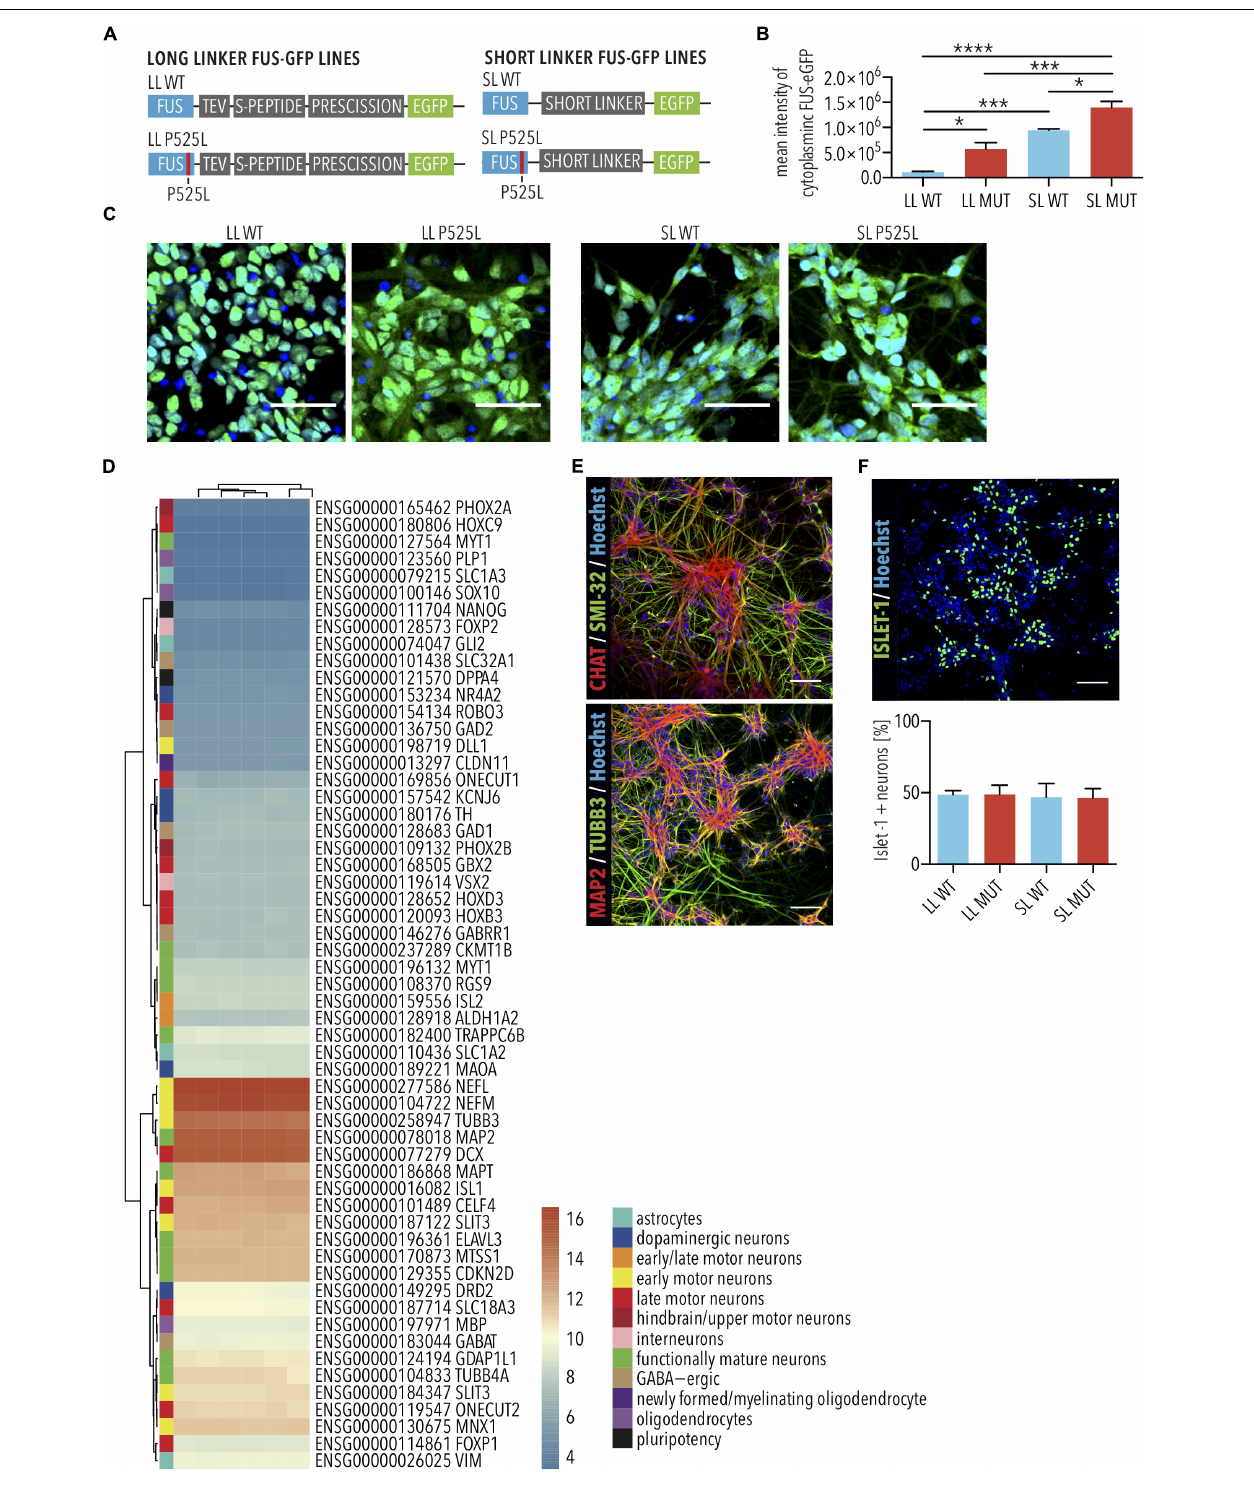
FIGURE 1 | Characterization of FUS-eGFP induced pluripotent stem cell (iPSC)-derived spinal neurons. (A) Schematic view explaining long (LL) and short linker (SL) (gray) connecting eGFP (green) to the C-terminus of wild type and P525L FUS (blue). (B,C) Spinal neurons with LL and SL P525L FUS-eGFP lines show increased mislocalization of FUS-eGFP to the cytoplasm compared with WT controls and, previously shown (Marrone et al., 2019), SL enhances mislocalization by disrupting the function of the adjacent nuclear localization signal. Quantified by mean intensity of cytoplasmic GFP. Scale bar = 50 µ m. n = 4. Error bars indicate SEM. ∗ , ∗∗∗